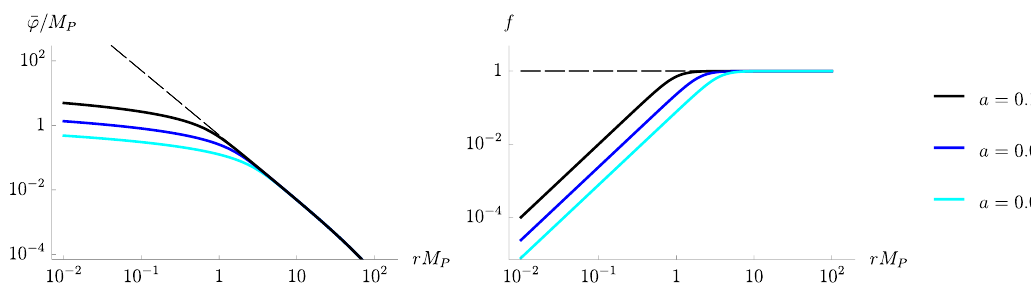
Figure 1 . The pro(cid:12)le of the singular instanton for the di(cid:11)erent values of a . The left panel demonstrates the logarithmic divergence of the scalar (cid:12)eld (cid:22) ’ in the core region of the instanton. The right panel shows the behavior of the metric function f in the same region. The dashed lines represent the static gravity